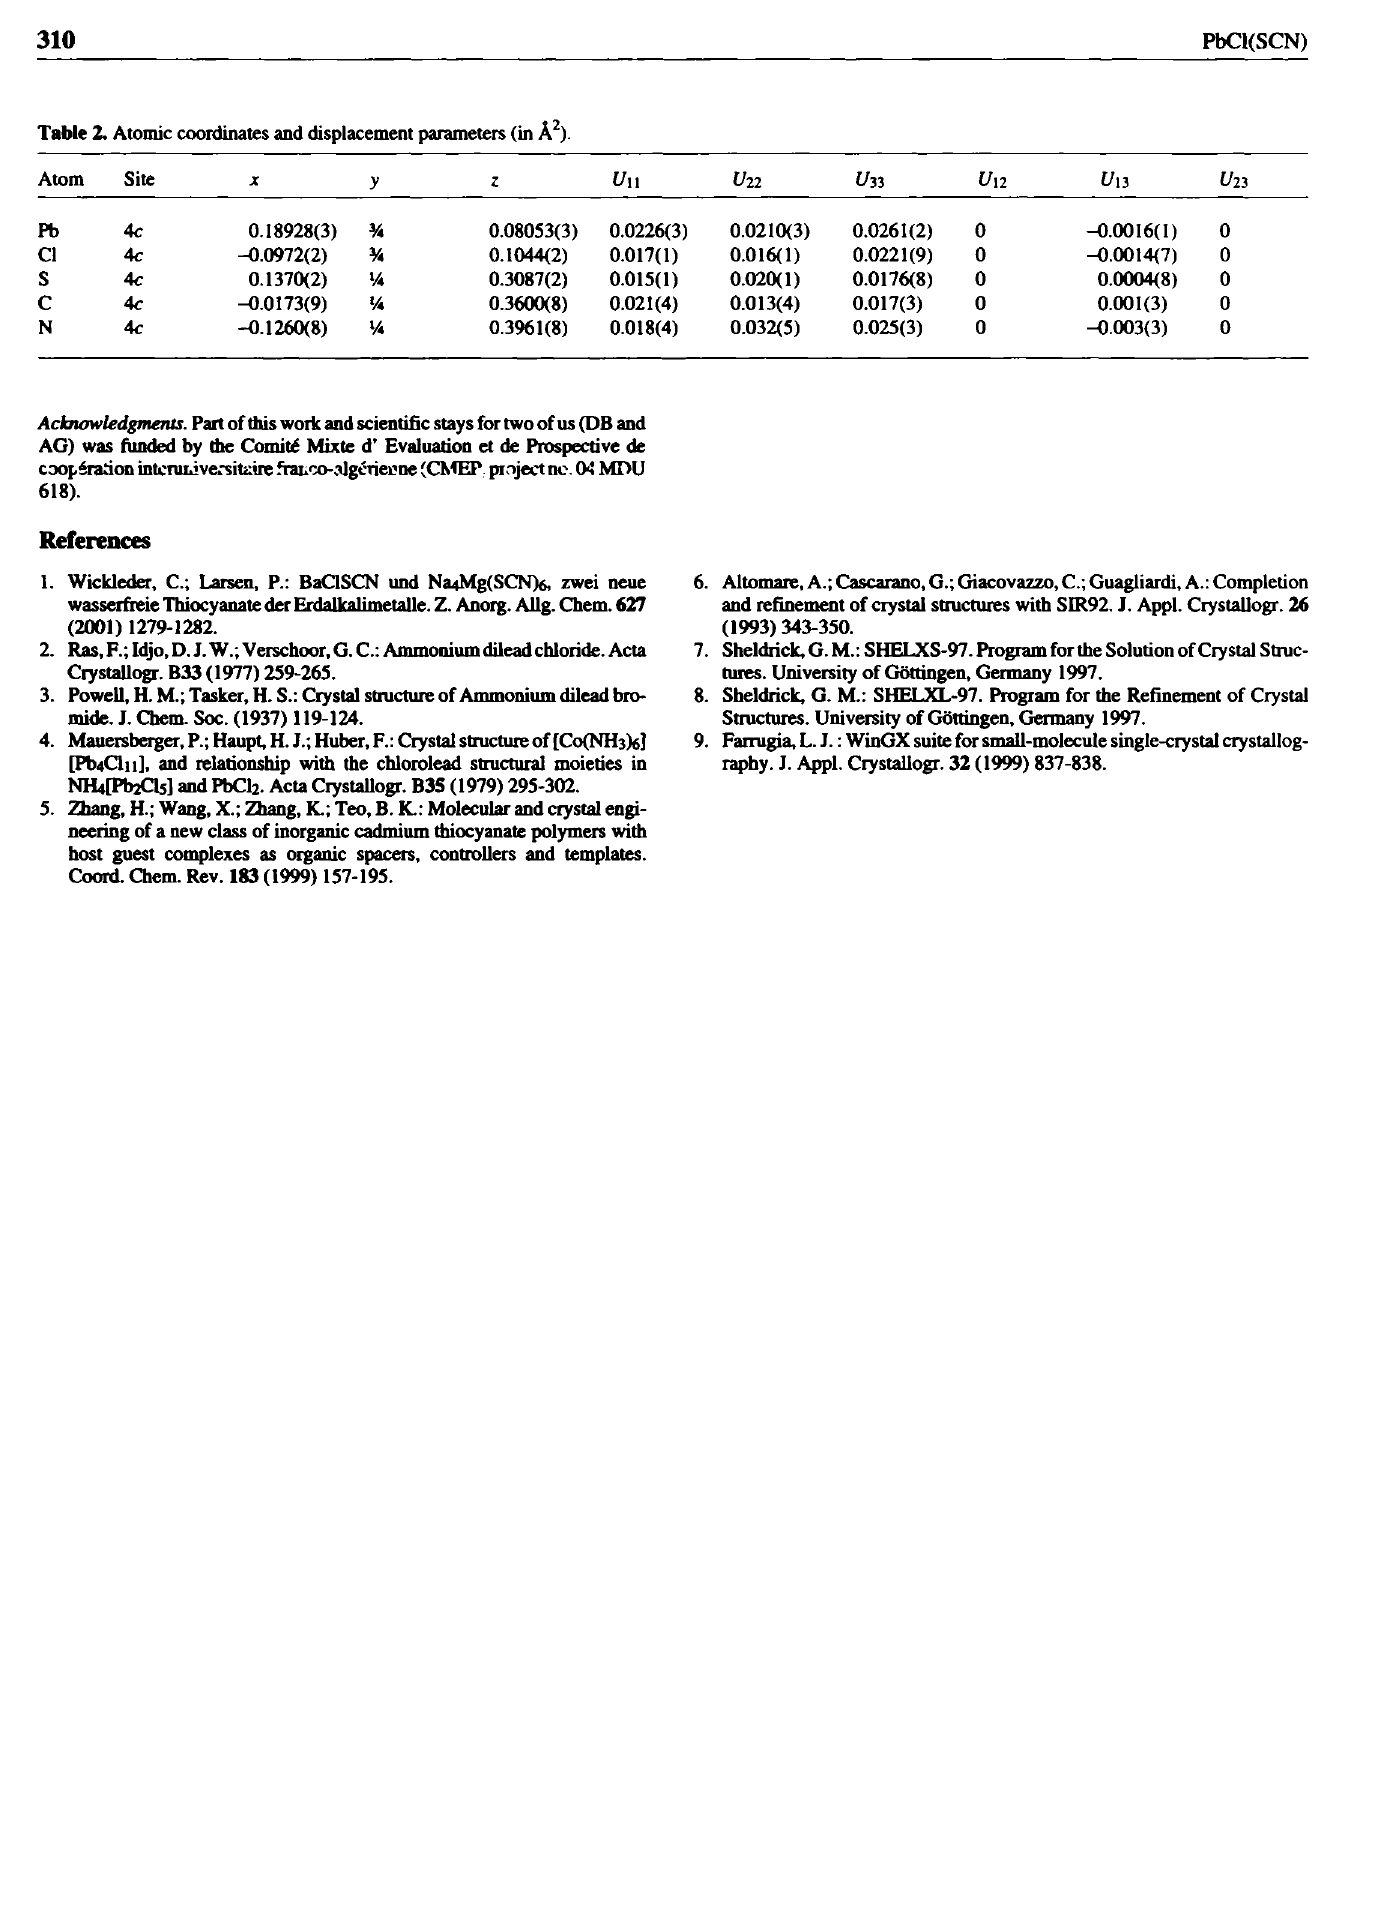
Table 2. Atomic coordinates and displacement parameters (in A 2 ).